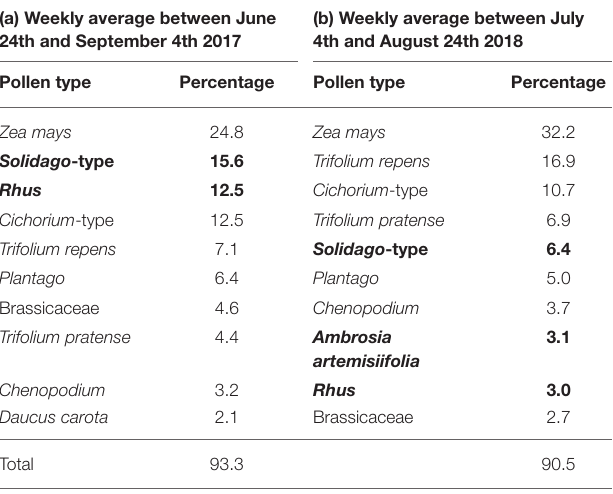
TABLE 2 | Percentage of pollen collected from the top ten most important host plants by honey bee colonies in (a) Saginaw and Tuscola counties, 2017; (b) Gratiot, Isabella, Midland, Saginaw and Tuscola counties, 2018.